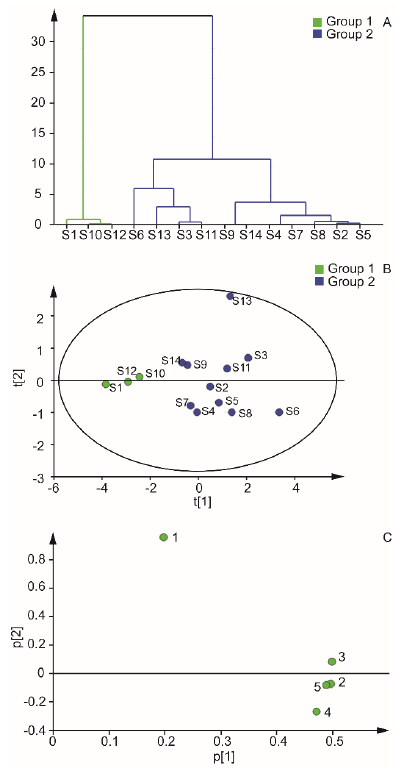
Figure 5. Cluster analysis and principal components of 14 samples. ( A , B , and C are dendrogram, score plot, and loading scatter plot, respectively.)